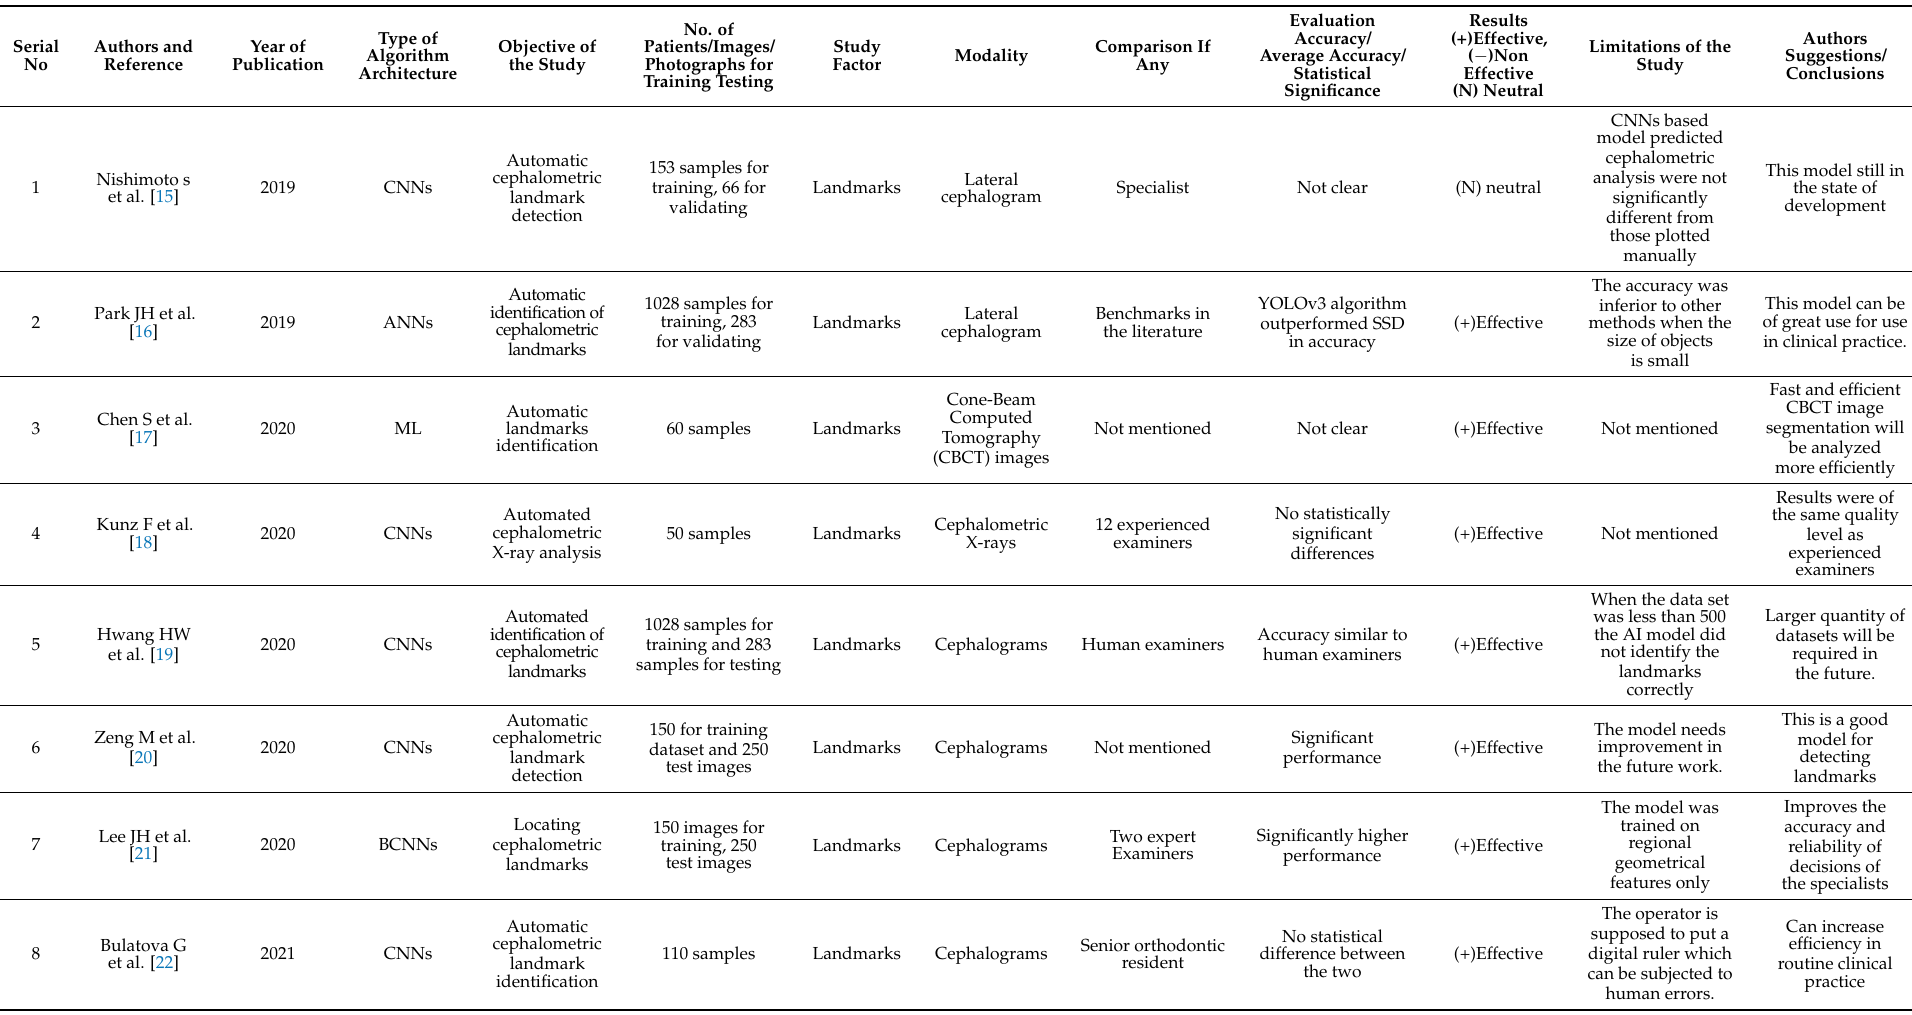
Table 1. Details of the studies that reported in application of AI based models in